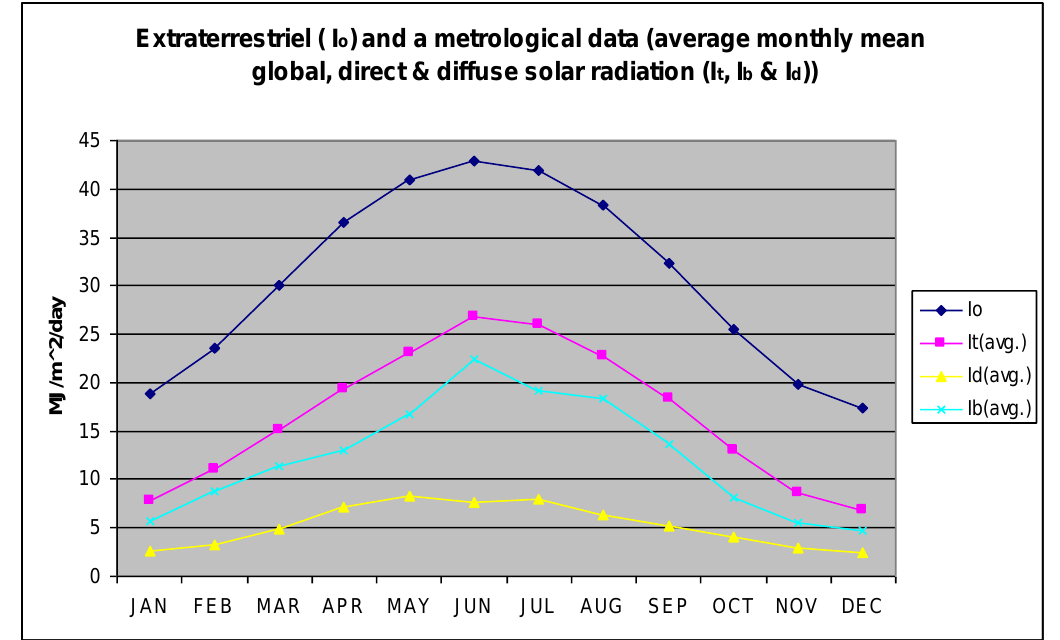
I and metrological data Fig. 3: Illustrated the monthly distribution of the extraterrestrial o I I I ( ) , , o b t The correlation between the clearness index K t , diffuse coefficient K D and the direct transmittance K b